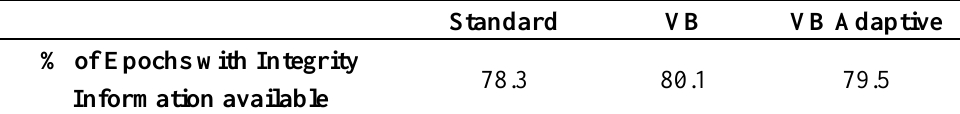
Table 3. Availability of GNSS integrity information (OEM6)—urban